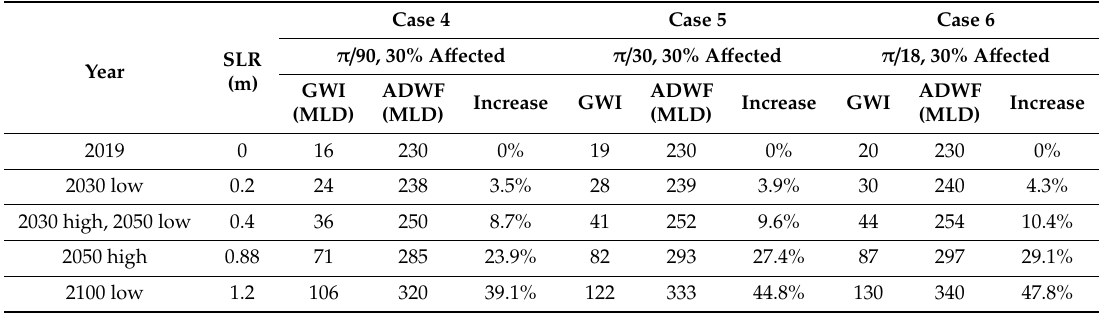
Table 1. Projected GWI due to SLR and its e ff ect on average dry weather flow (ADWF) at the wastewater treatment plant